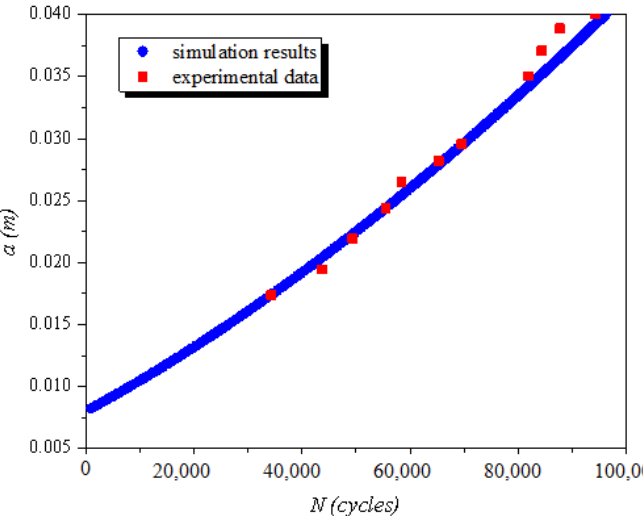
Figure 20. Comparison of crack propagation curves based on crack length a.